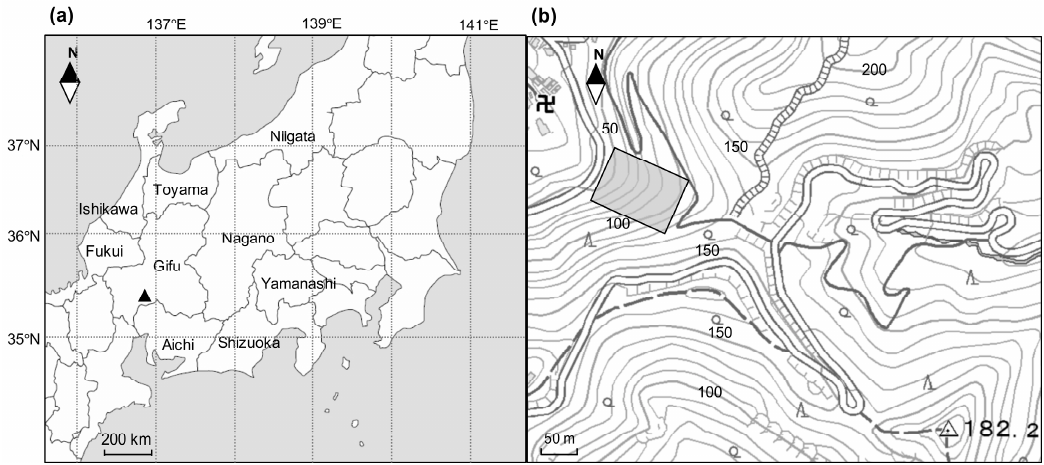
Figure 1. ( a ) location of the study site at Mt. Kinka ( ▲ ), central Japan; ( b ) the square indicates the permanent plot of 70 m × 100 m at the lower slope of Mt. Kinka. The contours signify elevation (m a.s.l.).